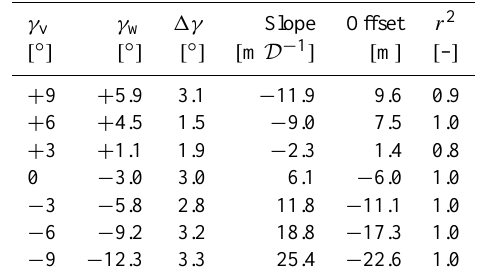
Table 2. Results of estimation of yaw misalignment from wake tracking ( γ w ) by linear regression through the last three stations of the near-wake path (1.0, 1.2, and 1.4 D ). Data classified in 3 ◦ bins with respect to yaw misalignment from nacelle vane ( γ v ).